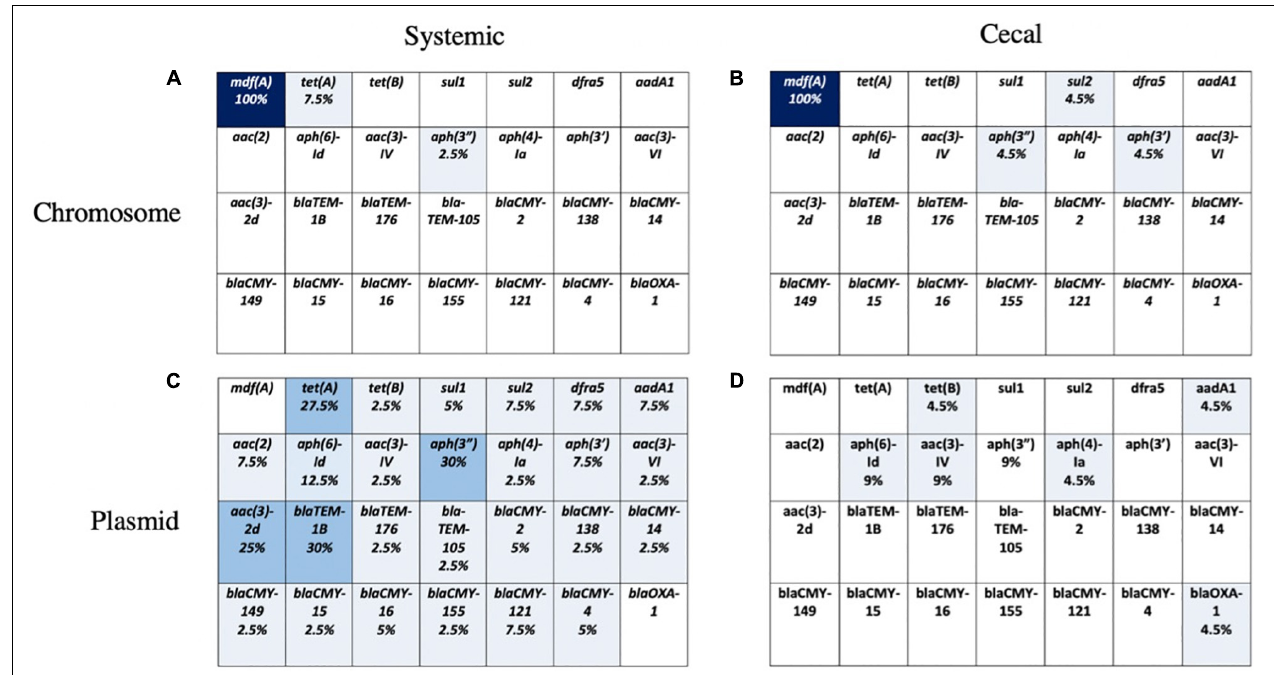
FIGURE 4 | Presence of 28 known AMR genes on chromosome and plasmid for systemic and cecal E. coli strains. Percent abundance of AMR genes on the chromosome of systemic E. coli (A) and cecal E. coli (B) or the plasmids of systemic E. coli (C) and cecal E. coli (D) . Light blue represents a proportion greater than 10%, medium blue = 10–30%, and dark blue represents greater than